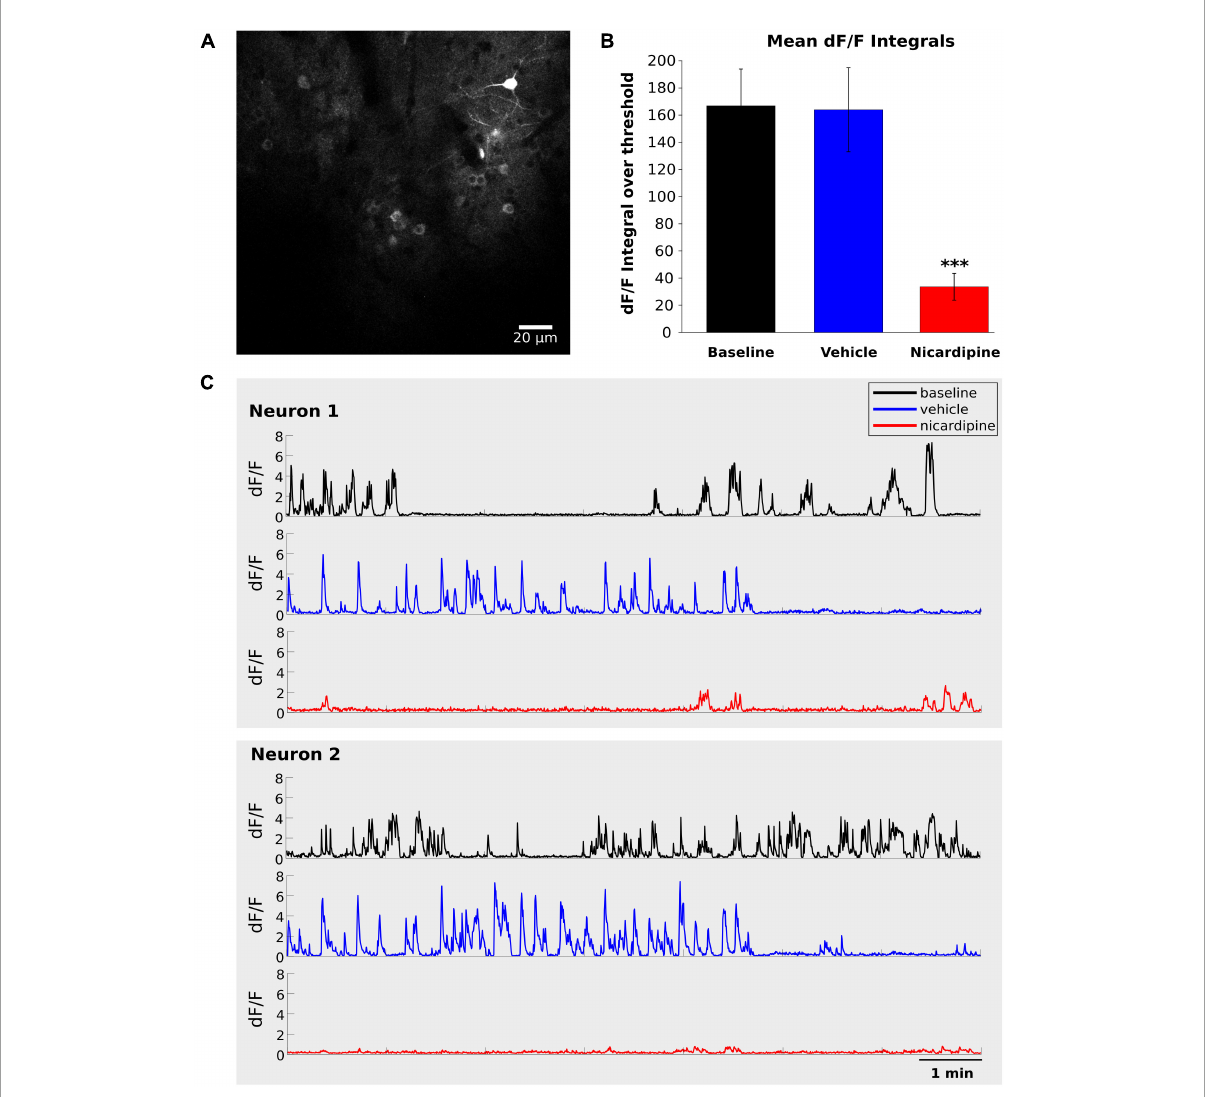
FIGURE2 Intracerebroventricular application of Nicardipine reduces cortical somatic calcium transients. Layer II/III neuron somatic calcium transients in in vivo two-photon imaging of GCaMP6f under baseline conditions, after ICV vehicle injection, and after ICV nicardipine injection. (A) Representative grayscale image of a field of view from one experiment. (B) Comparison of calcium signals under baseline conditions (black), after 40 min of ICV vehicle injection (blue), and after 100 min of ICV nicardipine injection. A threshold of 0.5 was applied to the dF/F signals (see section “Materials and methods”), which were then separately integrated over time for the three conditions. ( N = 3 animals; 63 neurons, 24 neurons, and 13 neurons), error bars are SEM. P values less than 0.001 are indicated with three asterisks. (C) Representative dF/F traces over time of two neurons in the three conditions (black, baseline; blue after vehicle injection; red after nicardipine